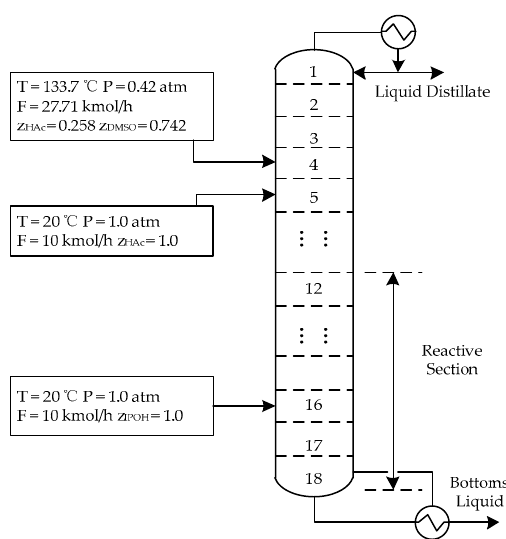
Figure 5. Schematic diagram of the isopropyl acetate reactive distillation column.